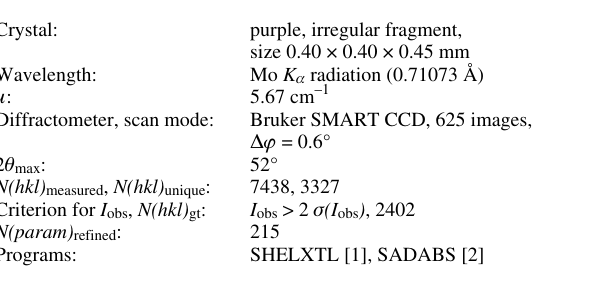
Table 1. Data collection and handling.